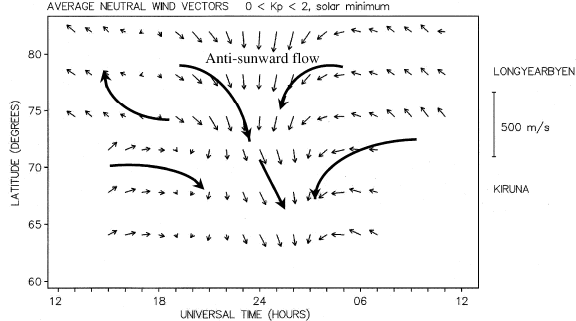
Fig. 2. Average large-scale thermospheric wind flow at high- latitudes (60 ◦ N–80 ◦ N) for geomagnetically quiet conditions (0 ≤ Kp < 2). Neutral gas motion is dominated by pressure gradients set up by solar heating, thus the flow is mainly anti-sunward.